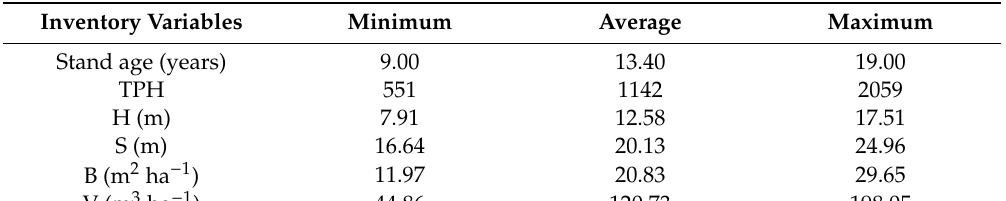
Table 2. Summary soil chemical characteristics in top 0 to 10 cm and foliar nitrogen before fertilization.